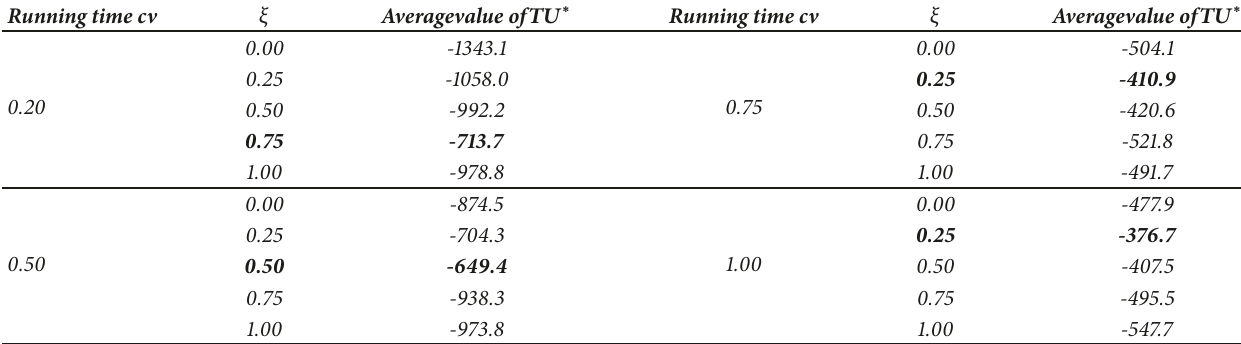
Table 1: Application